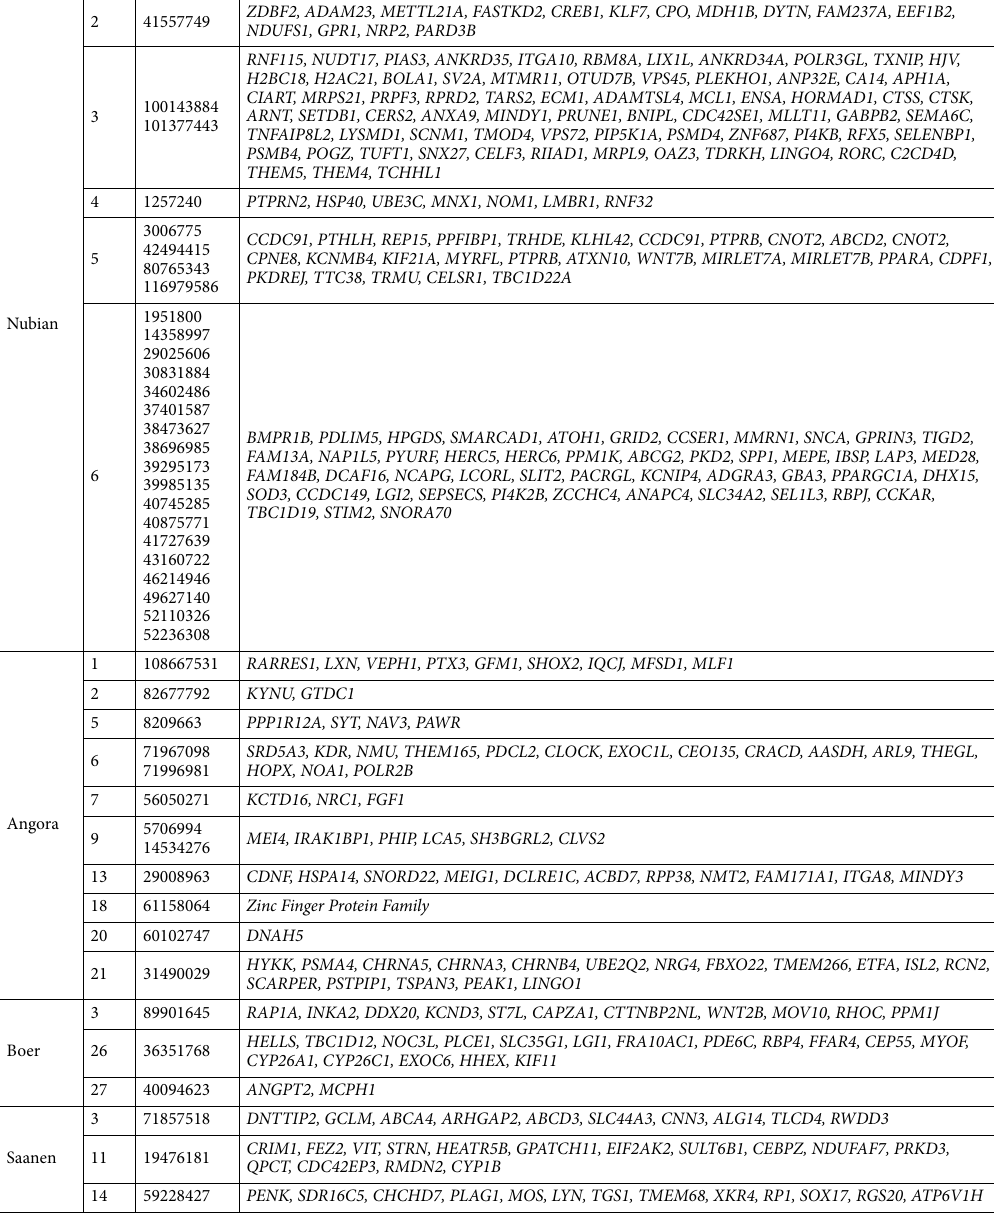
Table 1. List of candidate gene retrieved inside the genomic regions included in the interval of 1 Mb on both sides of each outlier SNP detected by